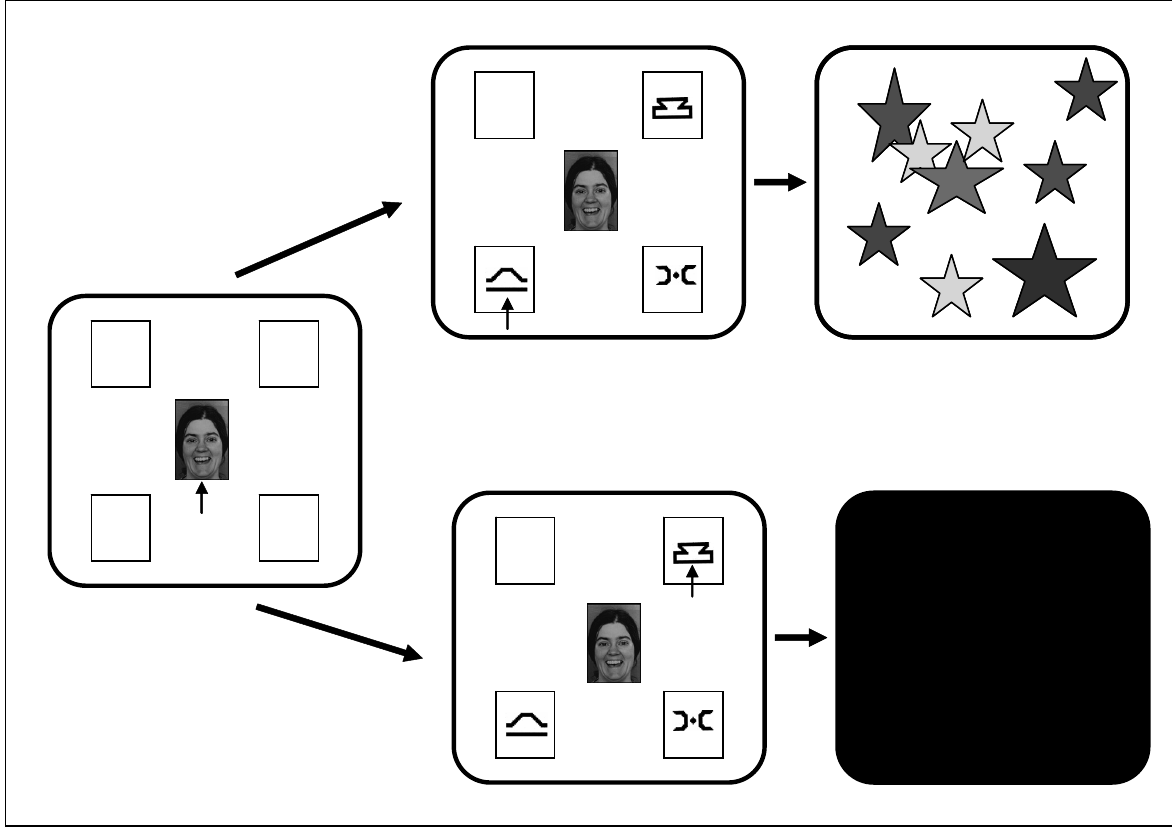
Figura 2 . Exemplo de tentativa de treino de discriminação condicional Nota . Primeiro, um estímulo era apresentado no centro da tela e o participante devia clicar nele. Em seguida, dois outros estímulos eram apresentados como opções de escolha. A escolha correta (parte superior da figura) era consequenciada com estrelas e sons; escolhas incorretas (parte inferior da figura) eram consequenciadas com uma tela